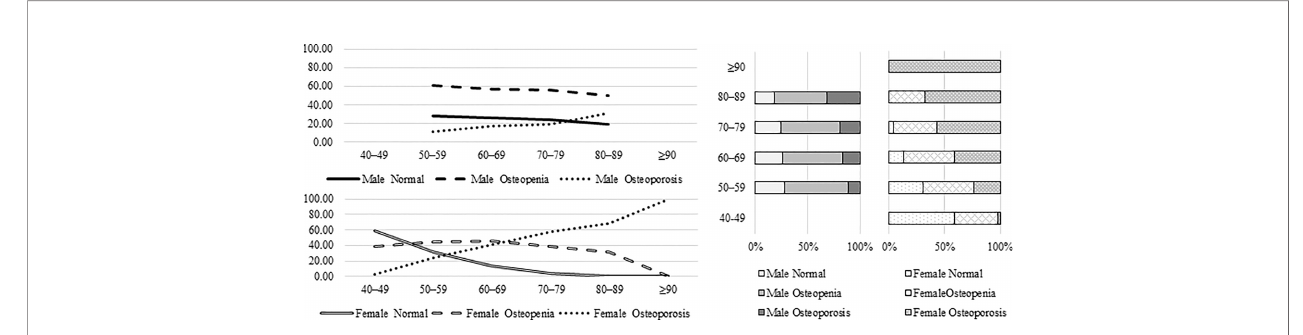
FIGURE 1 | The prevalence of osteoporosis in the participants by age and